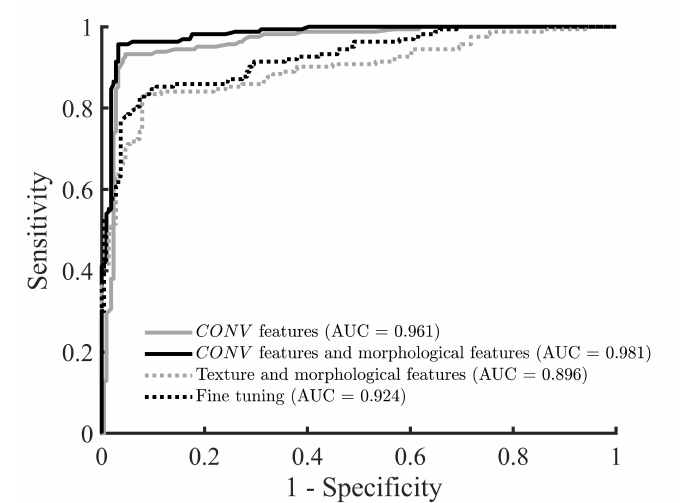
Figure 2. The ROC curves obtained using the CONV feature set (with features selection), the combined CONV feature set and morphological features (with features selection), the combined handcrafted texture and morphological features (with features selection), and the fine-tuned VGG19 CNN